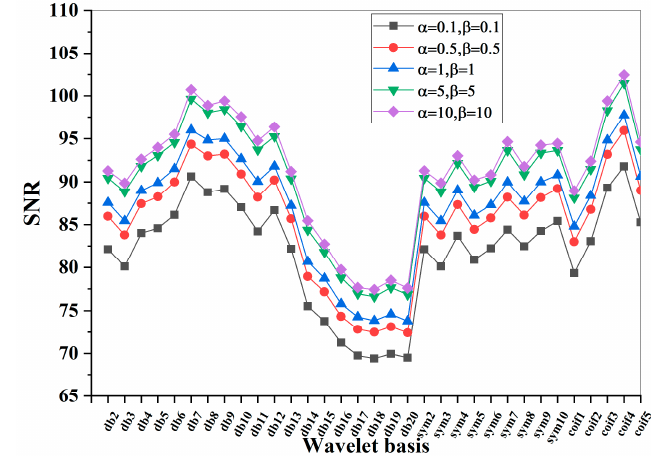
Figure 4. SNR values under different wavelet basis functions.